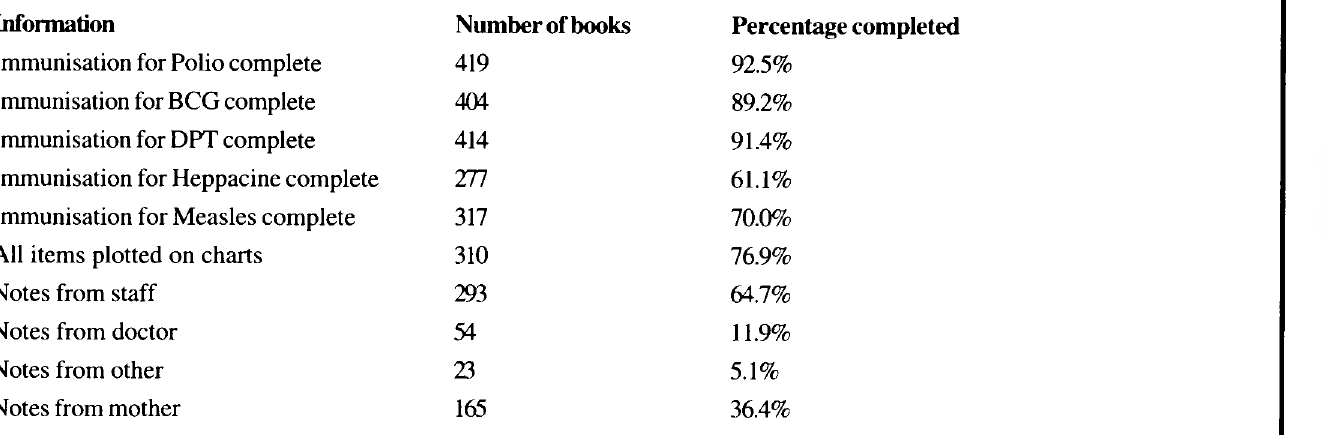
Table III: Information extracted from 453 RTH books completed by medical staff, clinic nurses and